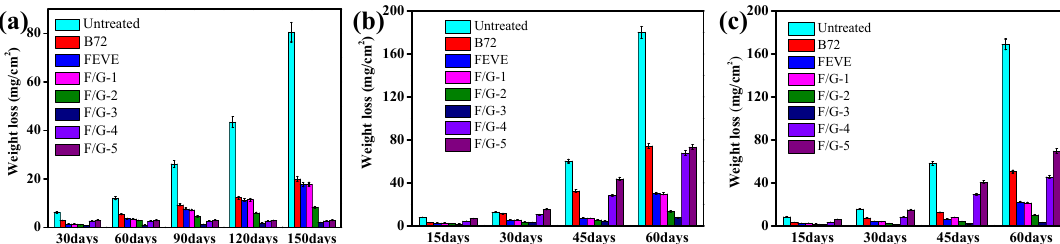
Figure 7. ( a ) Weight loss rate of simulated samples after ultraviolet light aging after treatment with B72, FEVE and F/G- X ( X = 1–5). ( b ) Weight loss of simulated samples of hygroscopic salt/pigment/consolidant agent system after B72, FEVE, F/G- X ( X = 1–5) treatment. ( c ) Weight loss of simulated samples of pigment/consolidant/hygroscopic salt system after B72, FEVE, F/G- X ( X = 1–5) treatment.